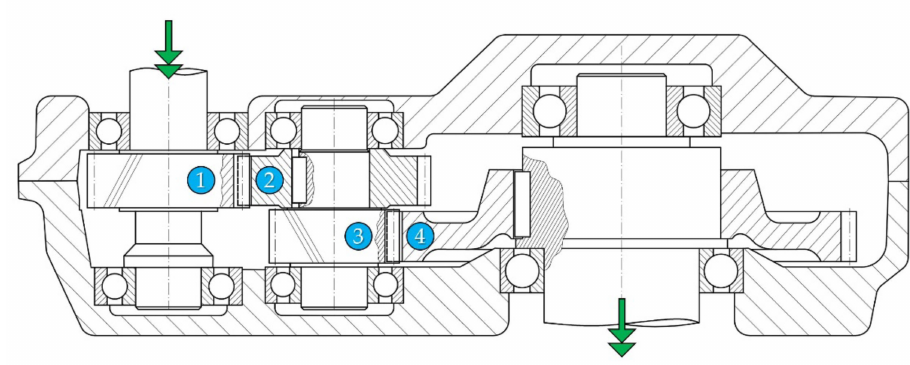
Figure 1. Cross-section of the gearbox.